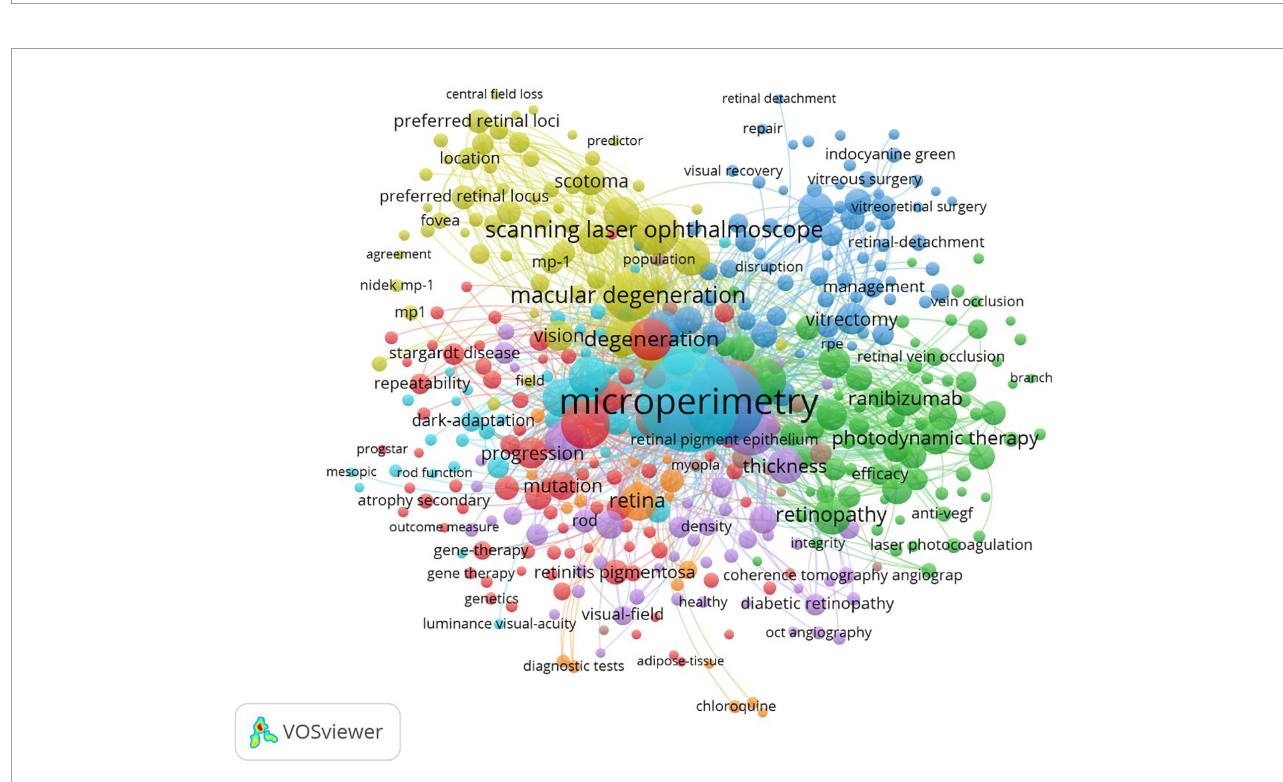
FIGURE9 Keyword analysis. The size of nodes demonstrated the number of occurrences of keywords. The curves between the nodes illustrated the co-occurrence between the two keywords. The color showed the clustering of